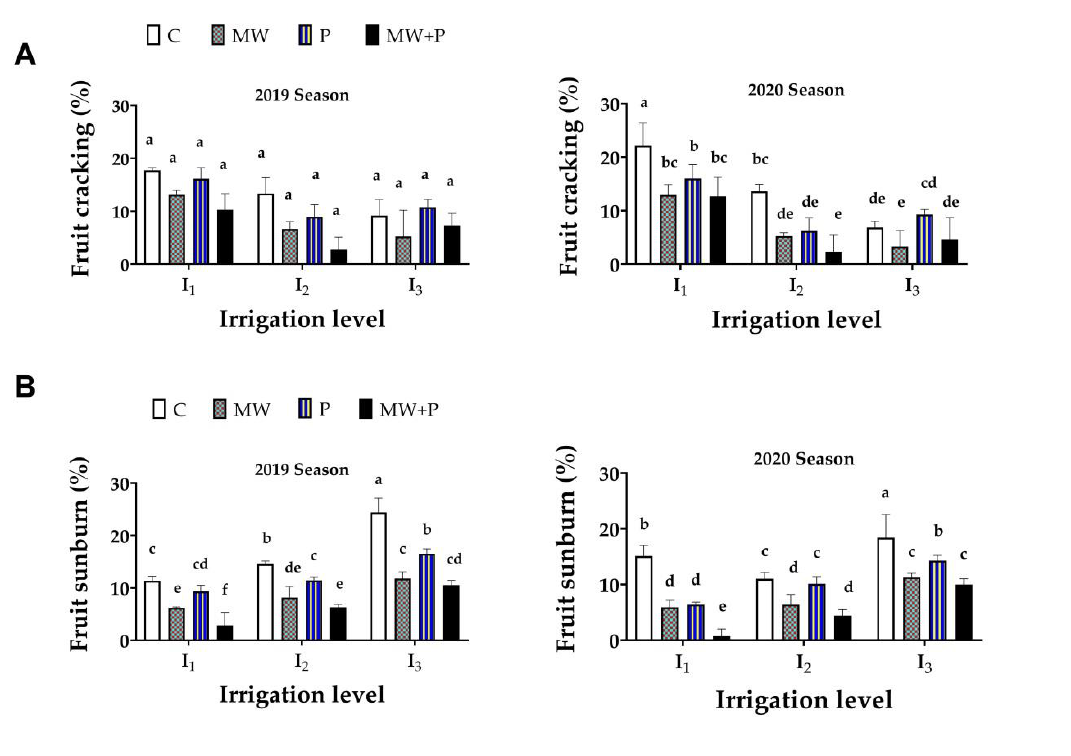
Figure 5. Effect of MW, P, and MW + P on fruit cracking ( A ) and sunburn ( B ) of “ Taifi ” pomegran- ate shrubs grown under different irrigation regimes (I 1 , I 2 , and I 3 ), based on CWR, during the 2019 and 2020 seasons. Values are the means ± SD. DMRT was used for mean comparisons at p ≤ 0.05.